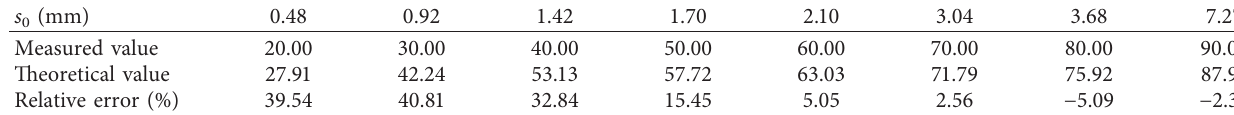
Table 5: Comparison of the theoretical and measured